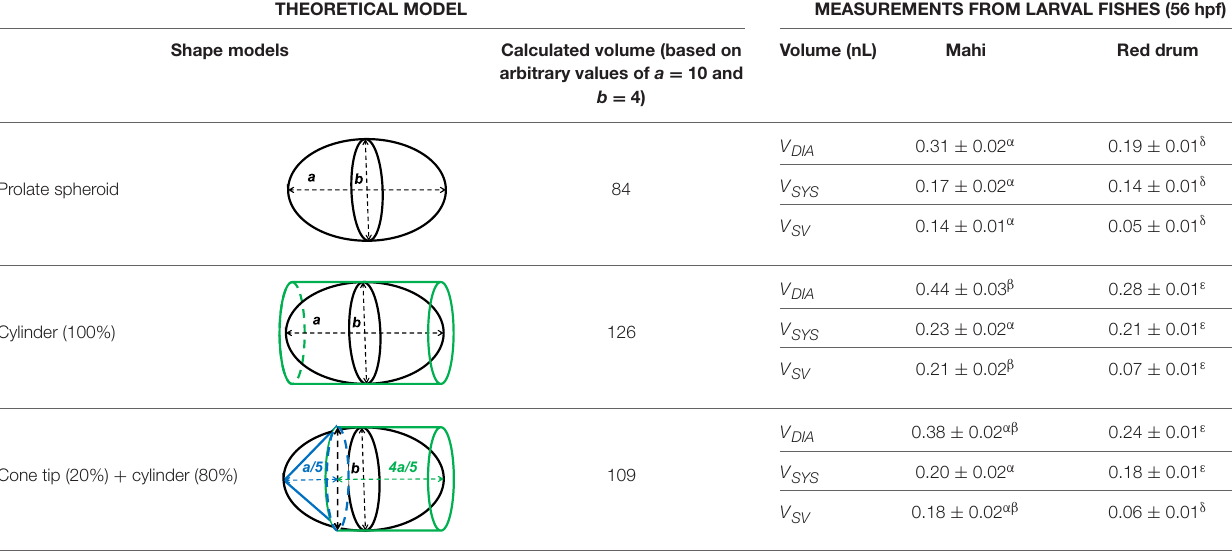
TABLE 2 | Modeling of heart volume in larval mahi and red drum at 56 hpf.